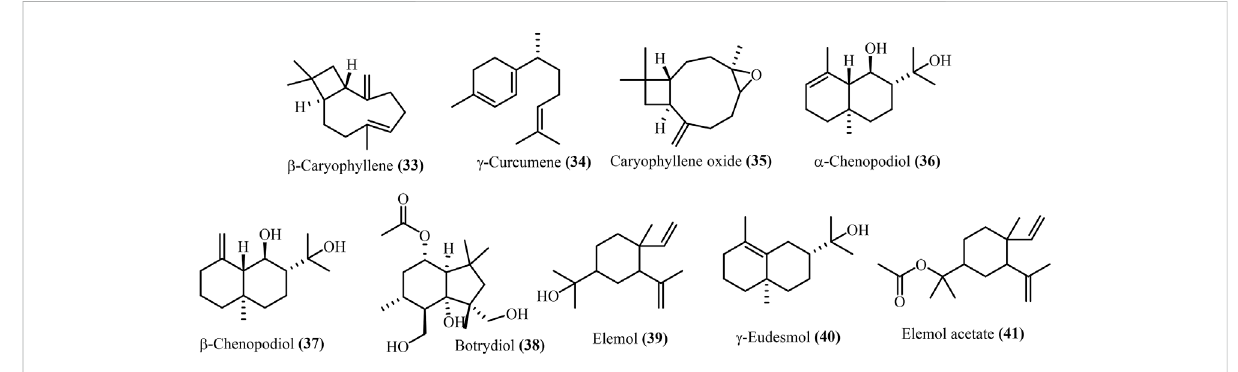
FIGURE 4 The Structure of the main sesquiterpenes in Dysphania spp essential